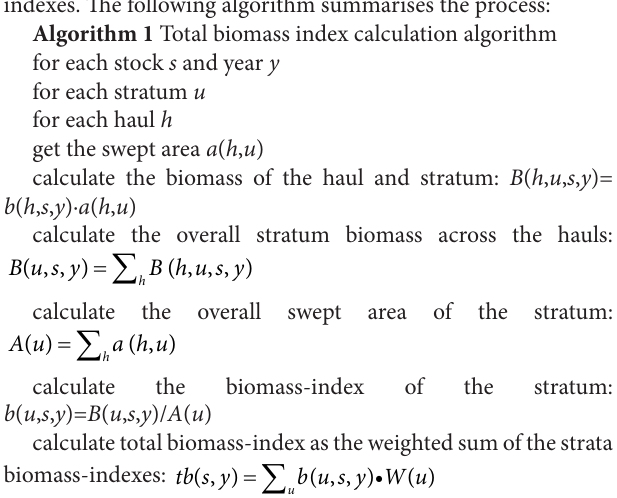
Algorithm 1 Total biomass index calculation algorithm